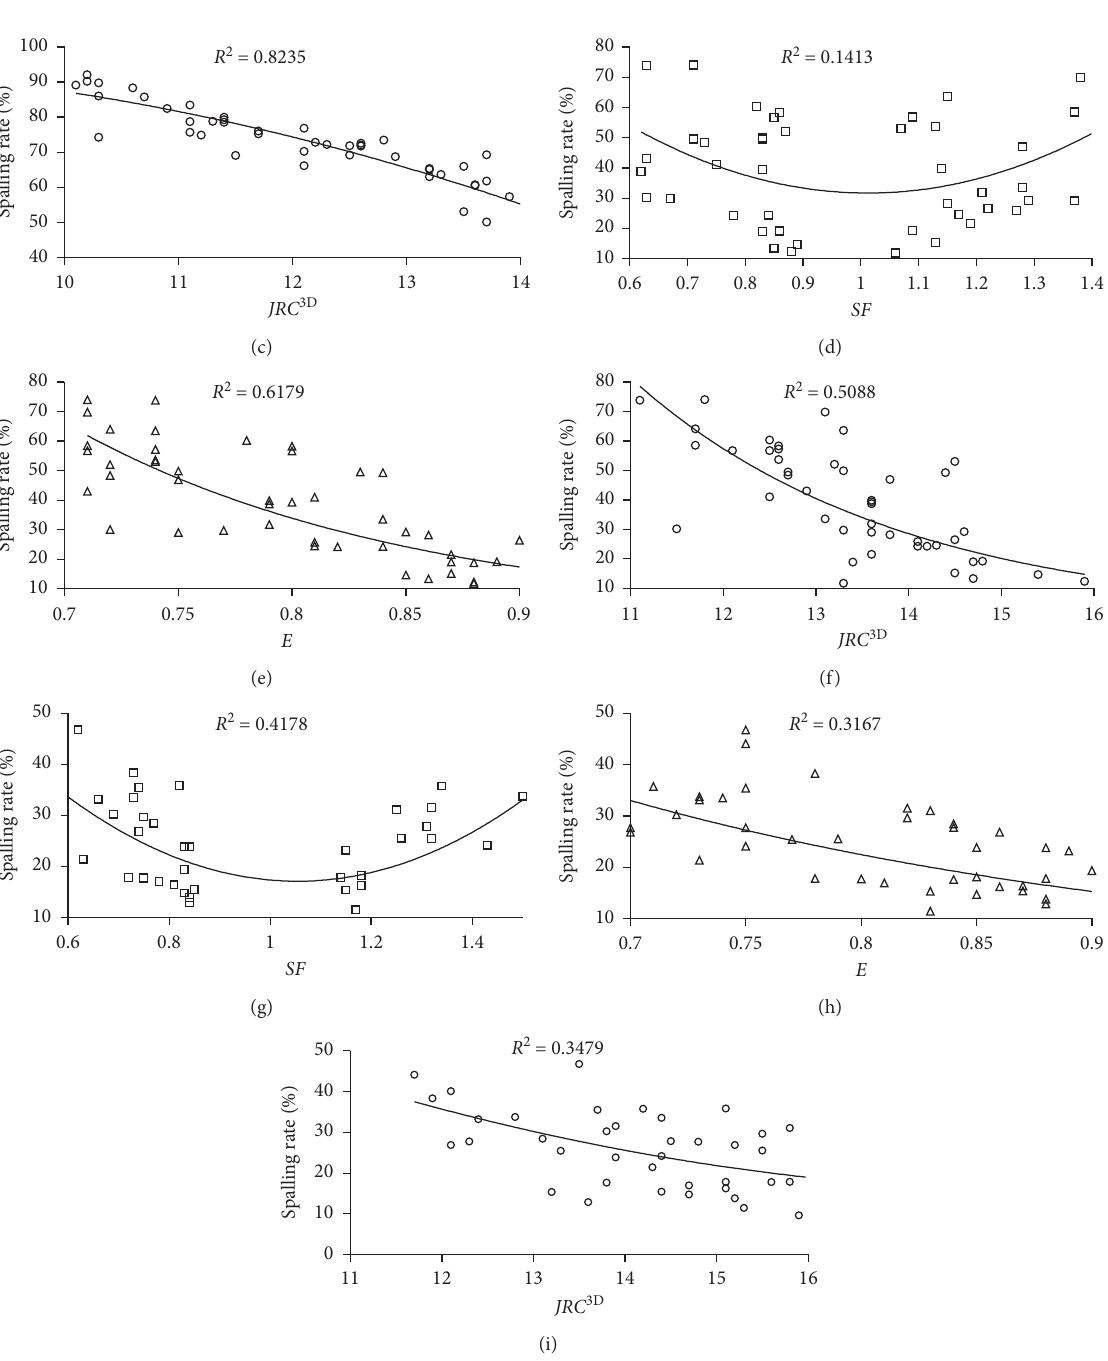
Figure 13: Influence of 3D morphology of the aggregate on adhesion of the aggregate and asphalt. (a) Correlation between the shape characteristics and the spalling rate of the granite aggregates. (b) Correlation between the angularity characteristics and the spalling rate of the granite aggregate. (c) Correlation between the roughness characteristics and the spalling rate of the granite aggregate. (d). Correlation between the shape characteristics and the spalling rate of the basalt aggregate.(e) Correlation between the angularity characteristics and the spalling rate of the basalt aggregate.(f) Correlation between the roughness characteristics and the spalling rate of the basalt aggregate. (g) Correlation between the shape characteristics and the spalling rate of the limestone aggregate. (h) Correlation between the angularity characteristics and the spalling rate of the limestone aggregate.(i) Correlation between the roughness characteristics and the spalling rate of the limestone